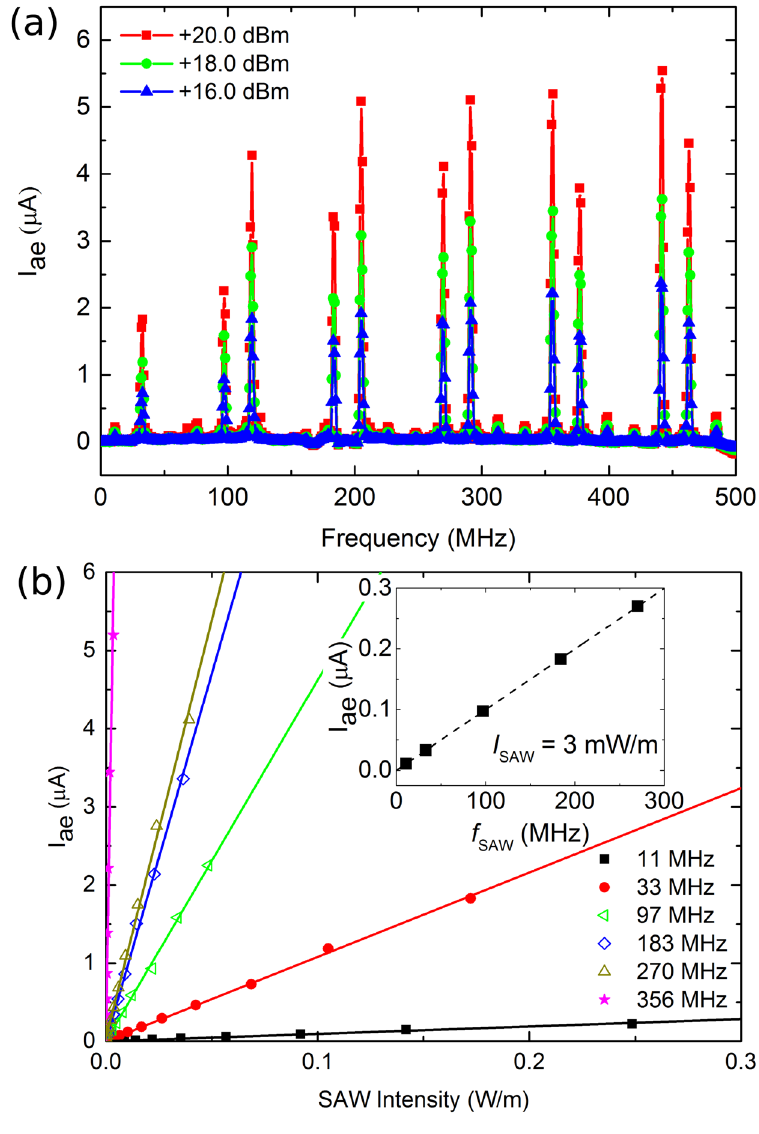
Figure 2. ( a ) Acoustoelectric current as a function of SAW frequency and RF power, as measured between contacts A and B (Device 1). ( b ) Acoustoelectric current as a function of SAW intensity at several SAW frequencies, as measured between contacts A and B (Device 1). Linear fits are guides to the eye. Inset: Acoustoelectric current as a function of SAW frequency for a fixed intensity. I ae is extracted from the linear fits in Fig.